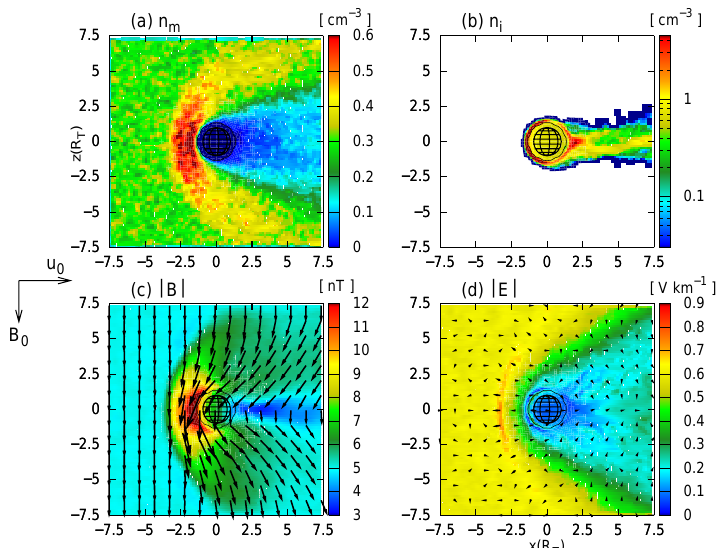
Fig. 5. Titan’s interaction with a slightly super-alfv´enic, supersonic and supermagnetosonic plasma flow – Cut through the polar plane. The figure displays (a) the ambient plasma density, (b) the ionospheric plasma density and the electromagnetic fields: (c) and (d) . Mach numbers of the upstream plasma flow: M A =1.87 (alfv´enic), M S =2.9 (sonic) and M MS =1.6 (magnetosonic).